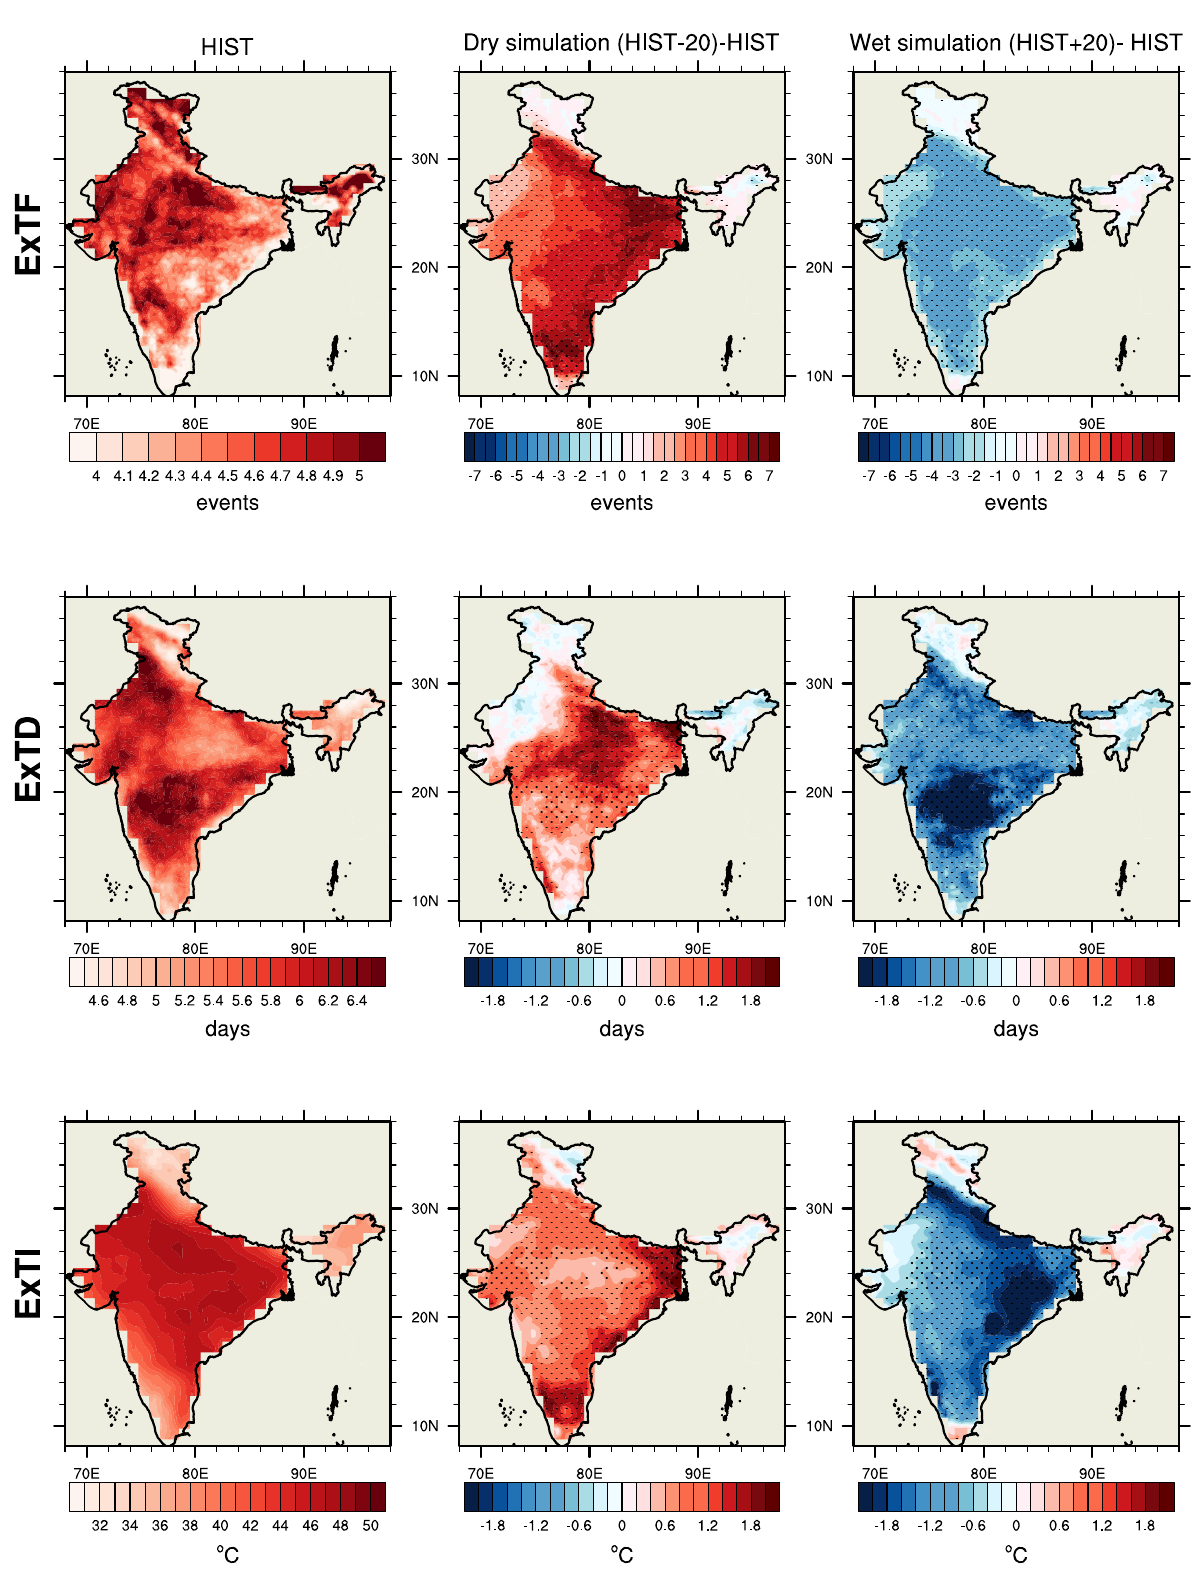
Fig. 5 Impact of SM on ExT for the historical period (1951 – 2010). Time-mean spatial maps of ExTF (1 st row), ExTD (2 nd row) and ExTI (3 rd row) from the HIST experiment (1 st column), difference between the HIST-20 and HIST experiments (2 nd column), and difference between the HIST + 20 and HIST experiments (3 rd column) during the historical period (1951 – 2010). Stippling in Figures indicate the regions where difference between the HIST-20/HIST + 20 and HIST experiment is signi fi cant at 95% con fi dence